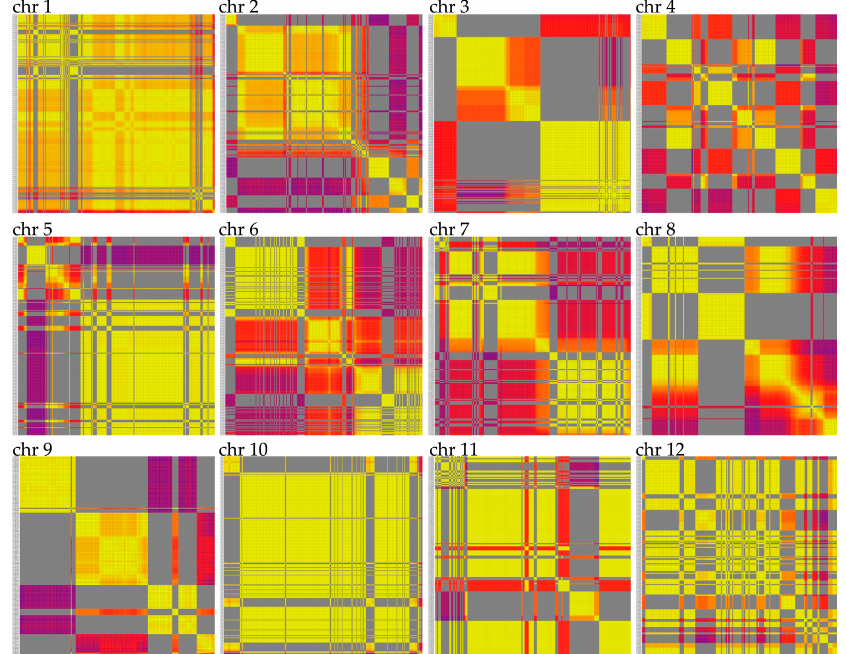
Figure A3. Heat maps for 12 linkage groups of the integrated genetic map for tetraploid potato. The heat maps consist of 12 maps from LG chr 1 to LG chr 12. Markers of each row and column are ranked according to the map order. Each small square represents the rate of recombination between two markers. Yellow color represents highly tight linkage; red color represents relatively weak linkage, the darker the red color, the less tight linkage; and blue color represents no linkage.